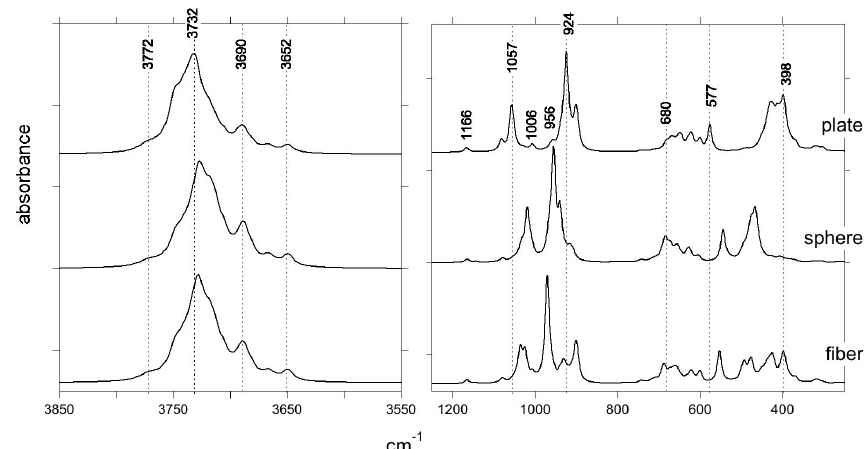
Figure 8. Theoretical infrared spectra of antigorite computed for three different particle shapes: (001) plate, sphere and cylindrical fiber elongated along the [010] direction. The spectrum of the plate corresponds to that displayed in Fig. 2. Note the sensitivity of the strong bands to the particle shape, whereas weak bands are weakly